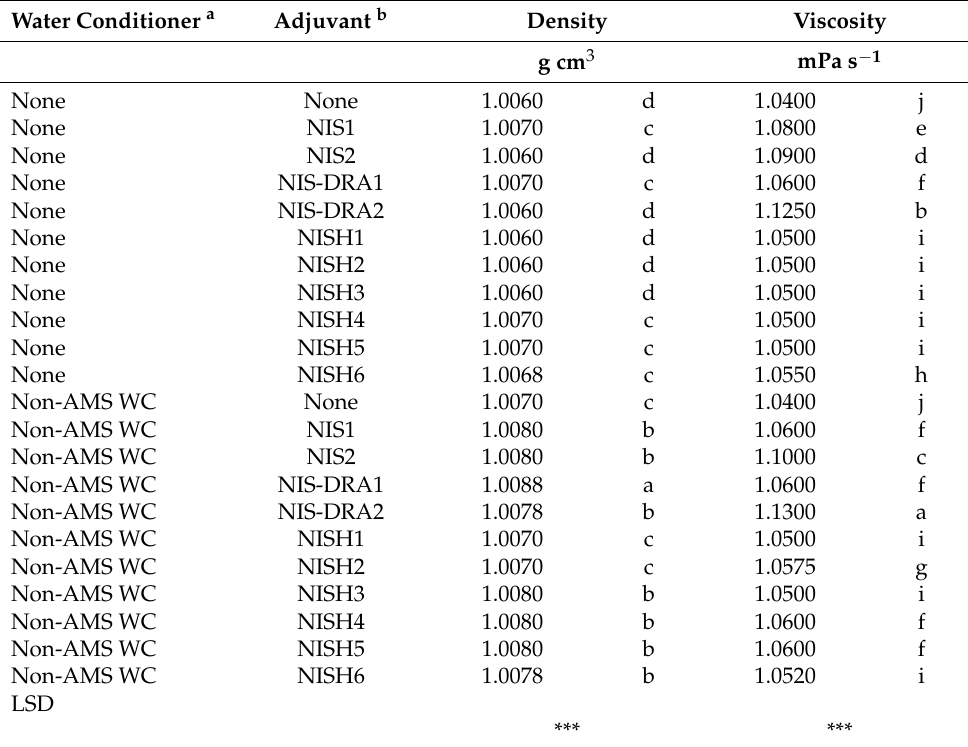
Table 3. Density and viscosity for dicamba plus glyphosate solutions at 559 and 1541 g ae ha − 1 , respectively, with and without non-AMS water conditioner alone and tank mixed with 10 adjuvants at 20 ◦